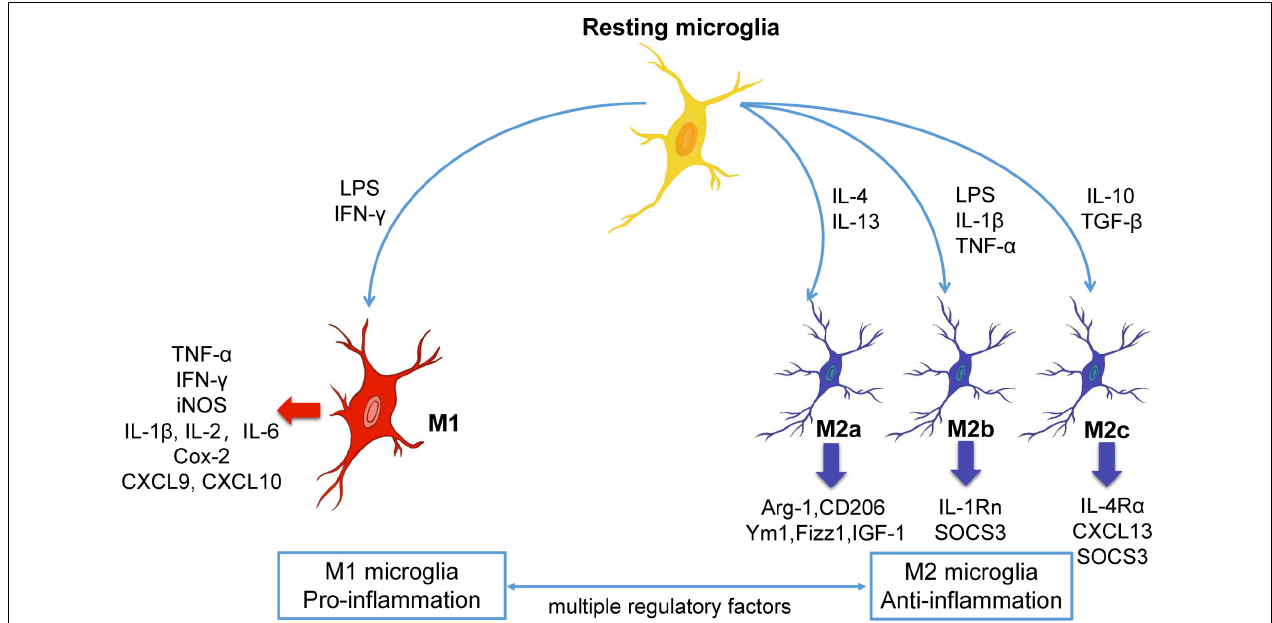
FIGURE 1 | The polarization and phenotypic transition of microglia. Microglia are remaining stationary under normal state, and different stimulators can induce the resting microglia to become different phenotypes. In general, M1 microglia are pro-inflammatory phenotype while M2 microglia are anti-inflammatory phenotype. M1 or M2 microglia can release different substances, and the microglia of the two phenotypes can be converted to each other under certain conditions. Arg-1, arginase-1; Cox-2, cyclooxygenase-2; CXCL, chemokine (C-X-C motif) ligand; IFN- γ , interferon- γ ; IGF-1, insulin growth factor-1; IL, interleukin; LPS, lipopolysaccharide; SOCS3, suppressor of cytokine signaling, TNF- α , tumor necrosis factor- α